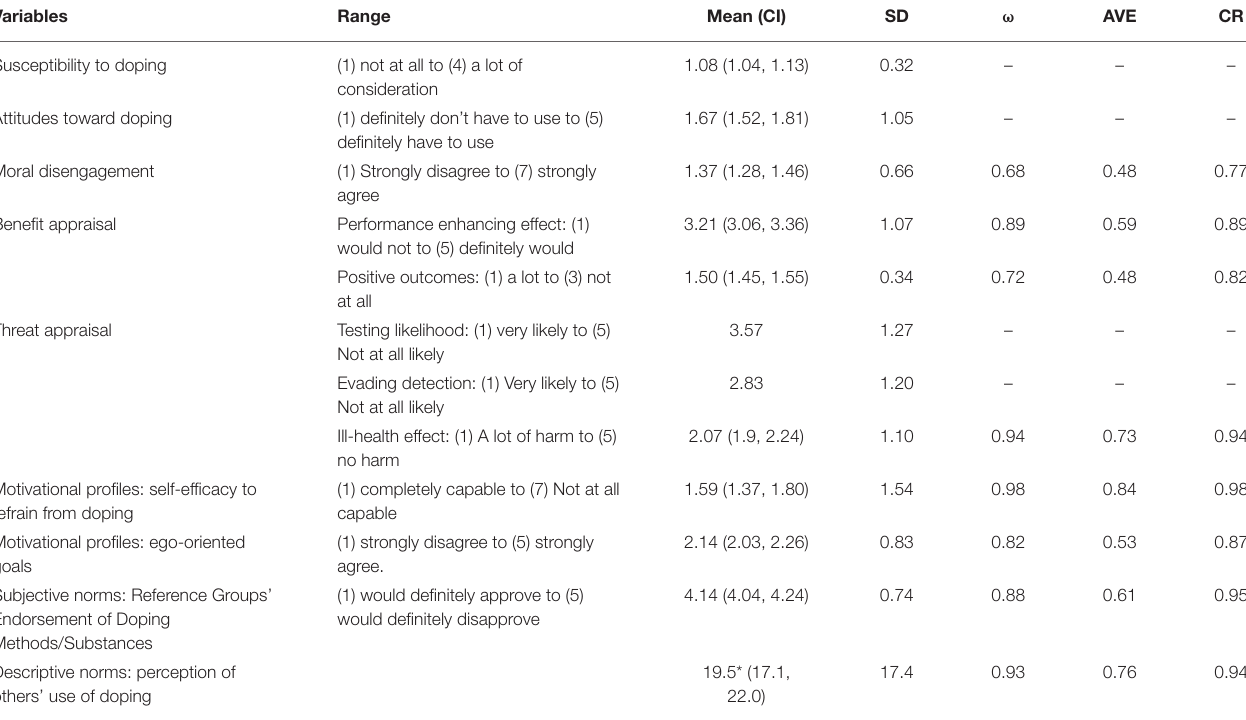
TABLE 1 | Descriptive statistics, reliability, and internal consistency estimates for the variables measuring the sport drug control model through structural equation modeling. Variables